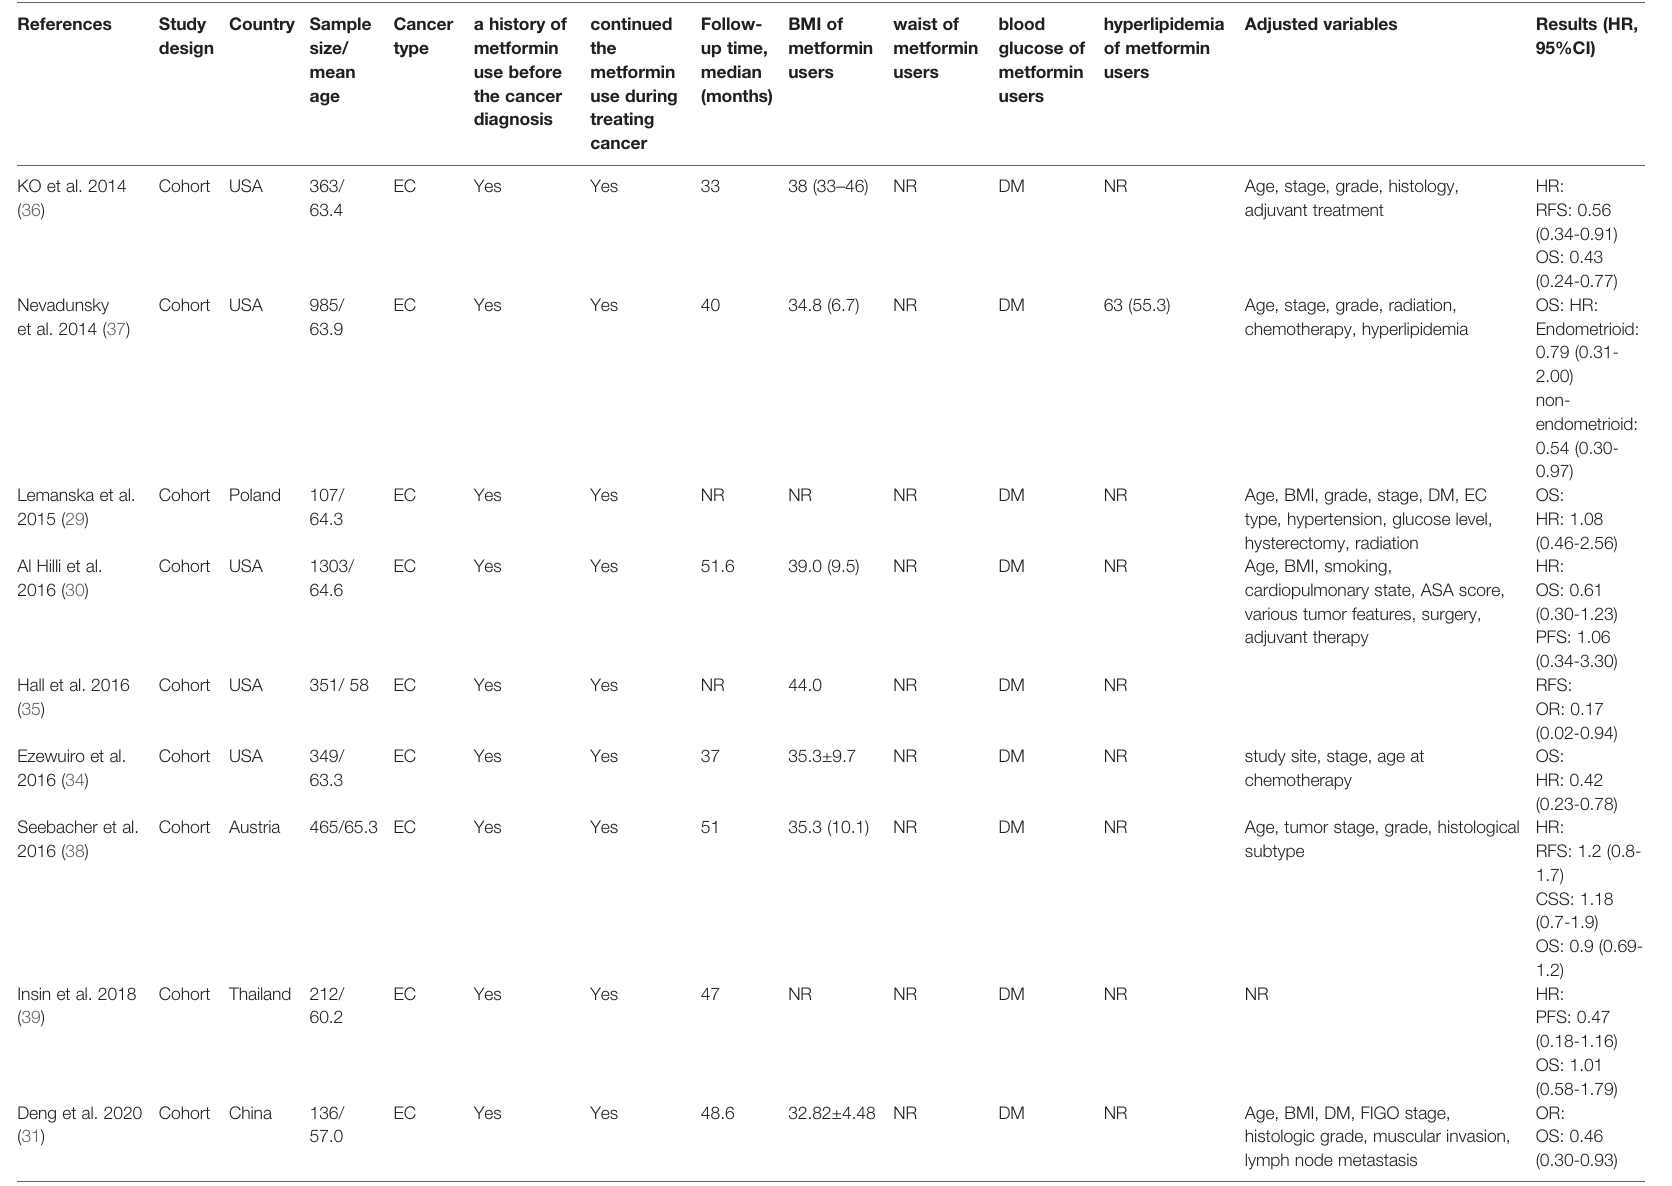
TABLE 2 | Characteristics of all included studies regarding association between metformin use and prognosis of gynecologic